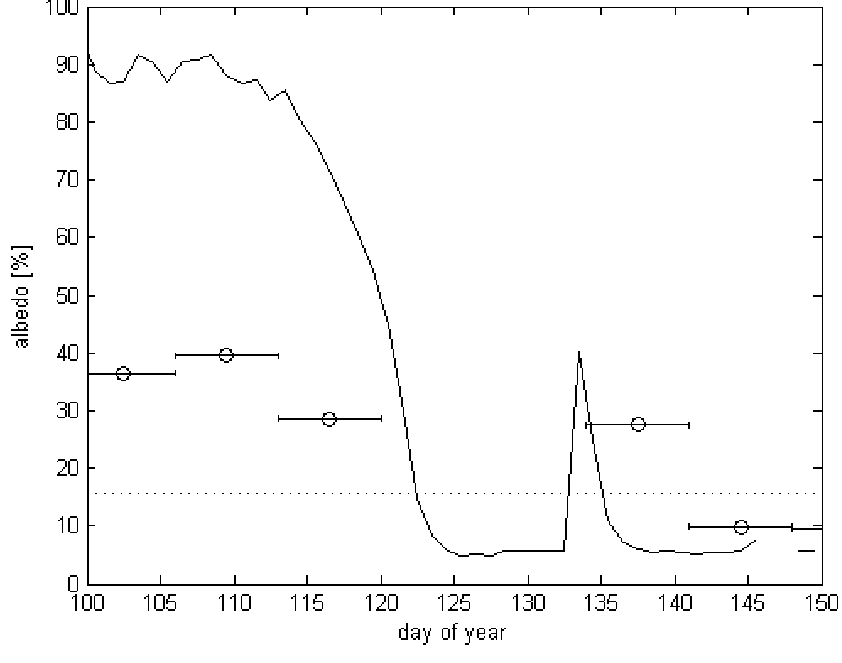
Figure 5. Time series of albedo at the Kaamanen mire measured locally (black solid line) and remotely (circles) in 2006. The error bars mark the periods from which the remotely- measured albedo are